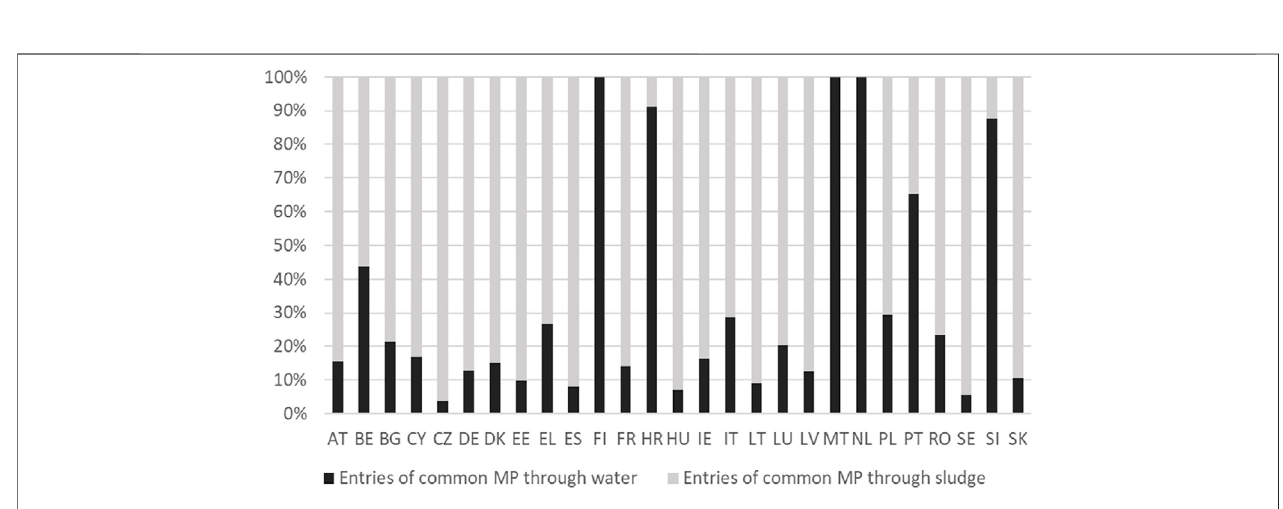
FIGURE2| environmentalinputsofcommonMPthroughsewagesludgeandthroughwater(someMSdonotusesludgeinagriculture,see Table2 ).Labelsonthe x -axis refer to country codes ( Table 2 ).